Question: Write a single sentence explaining what this figure depicts.
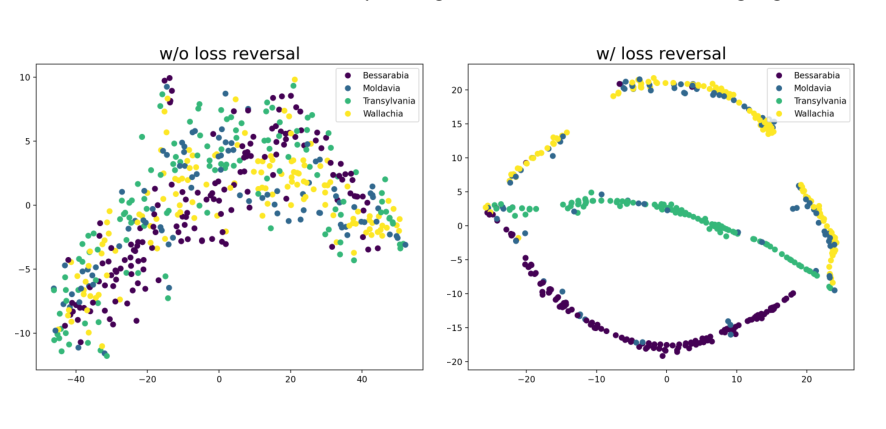
Answer: Clustering of the HistNERo test set embeddings produced by the BERT-large model using t-SNE with and without loss reversal.